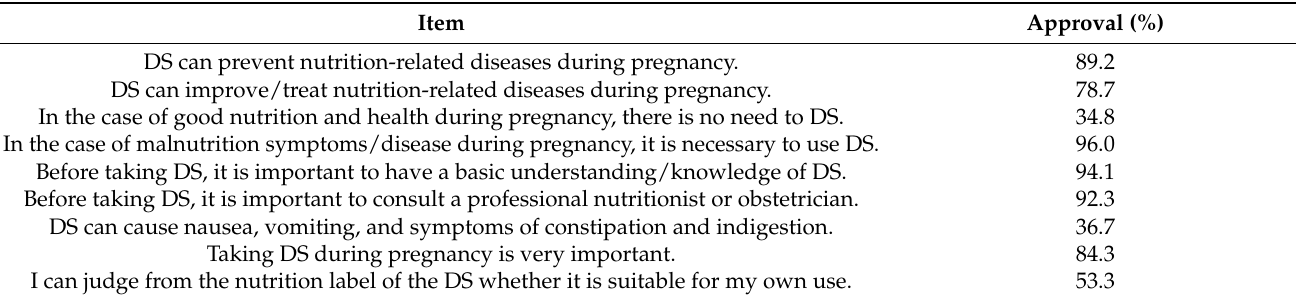
Table 3. Pregnant women’s perceptions of dietary supplement